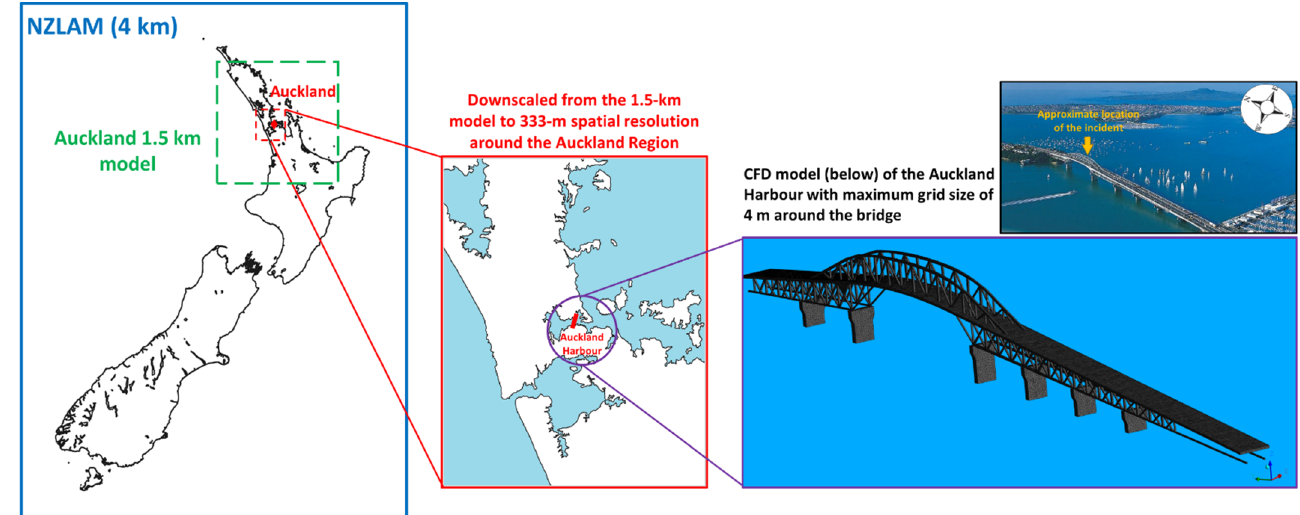
Figure 1. From left to right showing the process of the downscaling the 4-km NZLAM model (full model domain not shown) to 1.5-km (green box) and to the 333-m (red box) around the Auckland region. The outputs of the 333-m model are fed to the CFD simulation with a 4-m grid resolution around the Auckland Harbour Bridge. The yellow arrow shows the approximate location of the truck overturning incident.